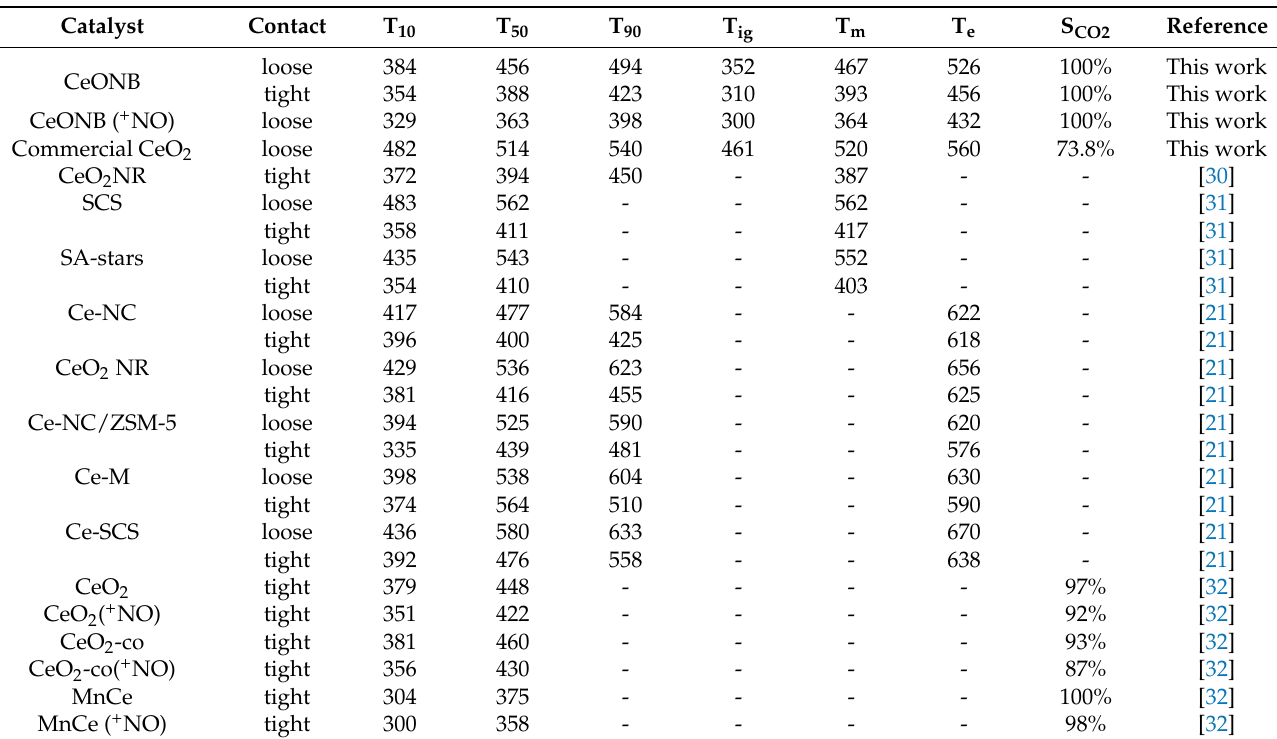
Table 3. Soot conversion by CeONB and other Ce-related